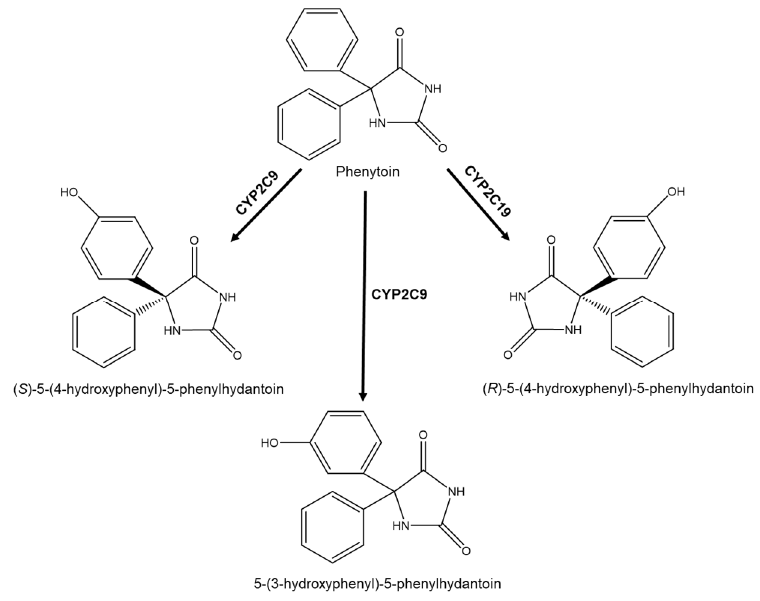
Figure 3. Phenytoin metabolism.